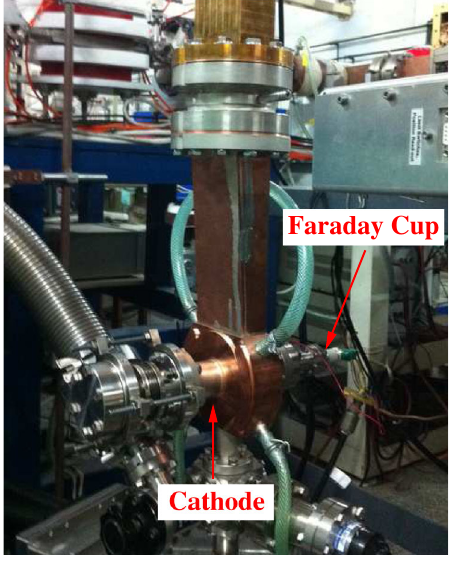
FIG. 11. The test stand.